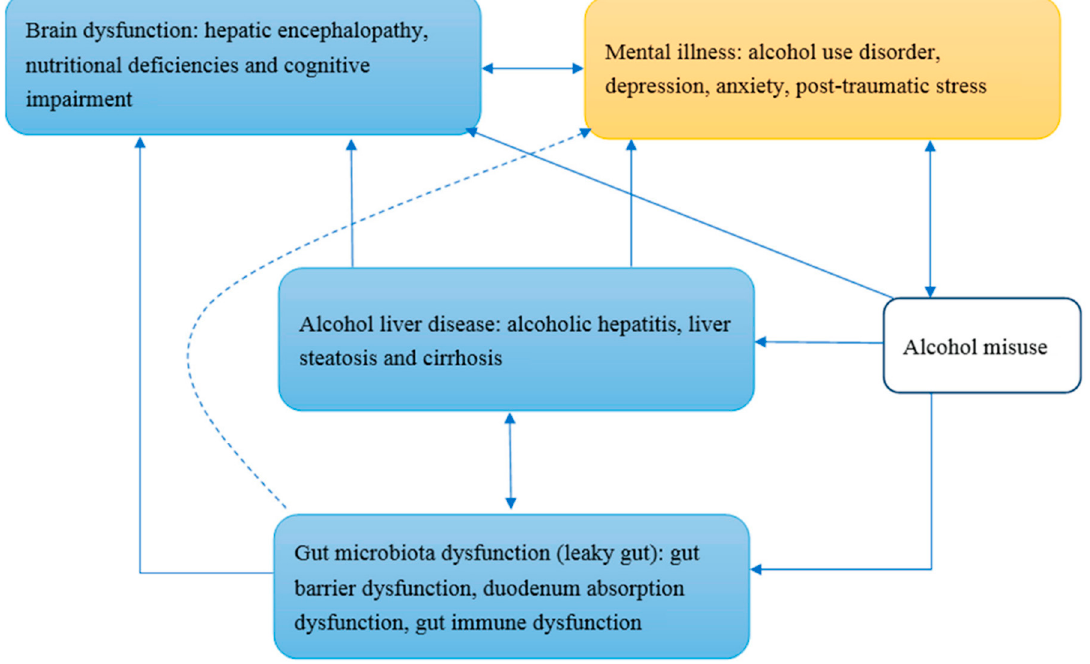
Figure 1. The conceptual framework of alcohol use disorder and the gut–brain–liver axis.